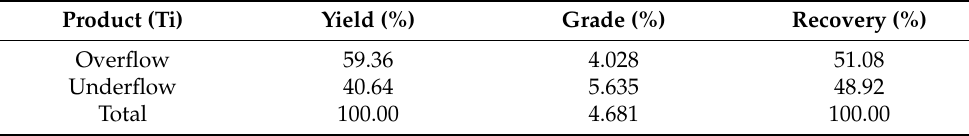
Table 4. Particle metal elements analysis.